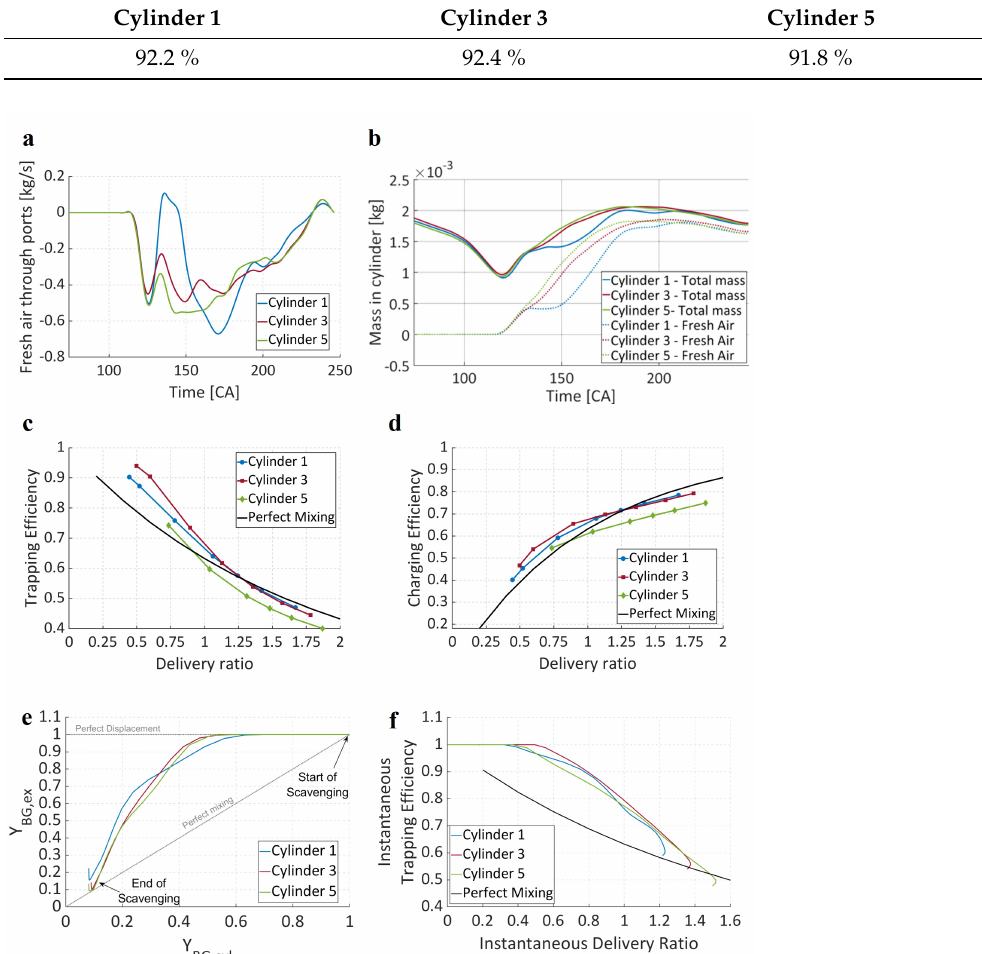
Figure 14. Scavenging performances of the GF56 right bank. ( a ) Computed Fresh Air flow through intake ports as a function of CAD for the three cylinders with G = G b . ( b ) Fresh Air and total mass trapped into the three cylinders as a function of CAD with G = G b . ( c ) Burned gas mass fraction in the exhaust ducts versus burned gas mass fraction in the cylinder for the three cases with G = G b . ( d ) Instantaneous trapping efficiency versus instantaneous delivery ratio for the three cylinders with G = G b . ( e ) Trapping efficiency of the three cylinders. ( f ) Charging efficiency of the three